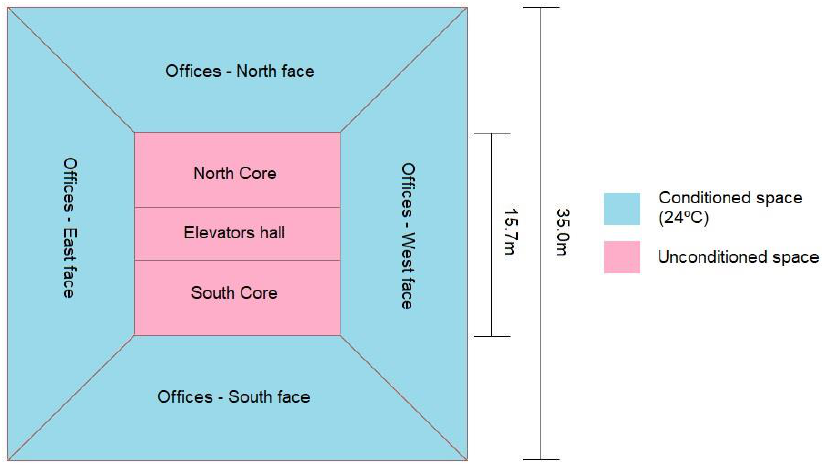
Figure 2. Building floor plan. Table 1. Representative cities for the Brazilian bioclimatic zones [18,19].